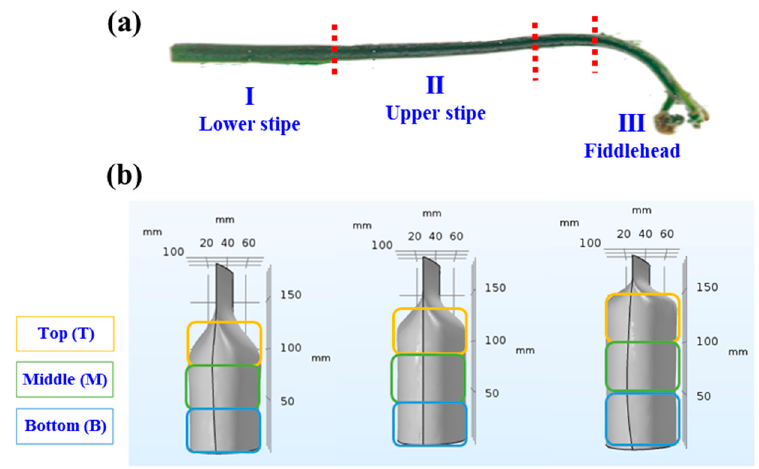
Figure 2. The sampling locations for textural measurements of sterilized BF. ( a ) Segment location on a BF stalk and ( b ) sampling location in a stand-up pouch. The red dashed line is to distinguish the section.